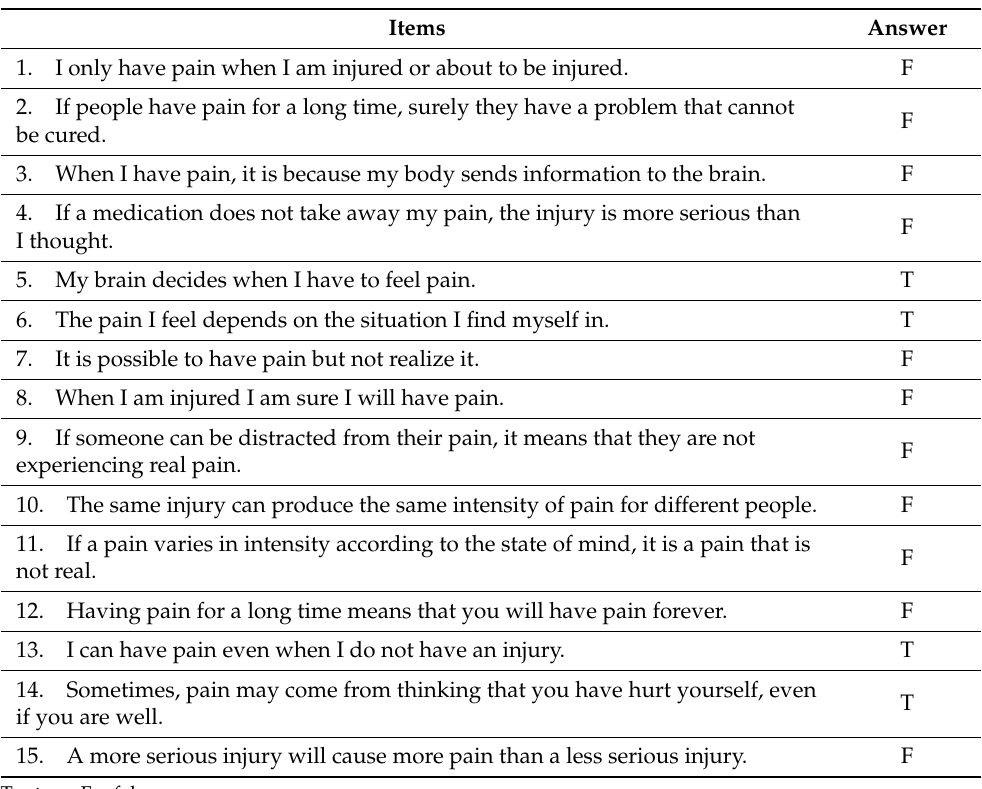
Table 1. Conceptualization of Pain Questionnaire translated into English.